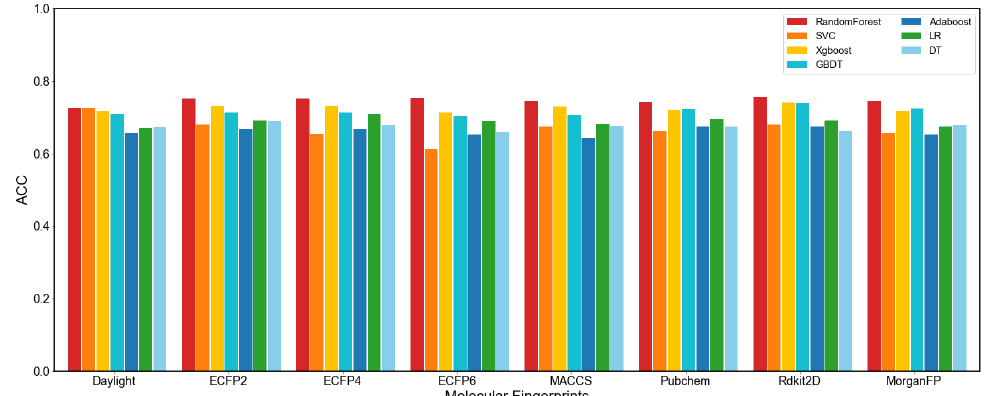
Figure 1. The performance of ACC in pre-experiment with different Fingerprints.